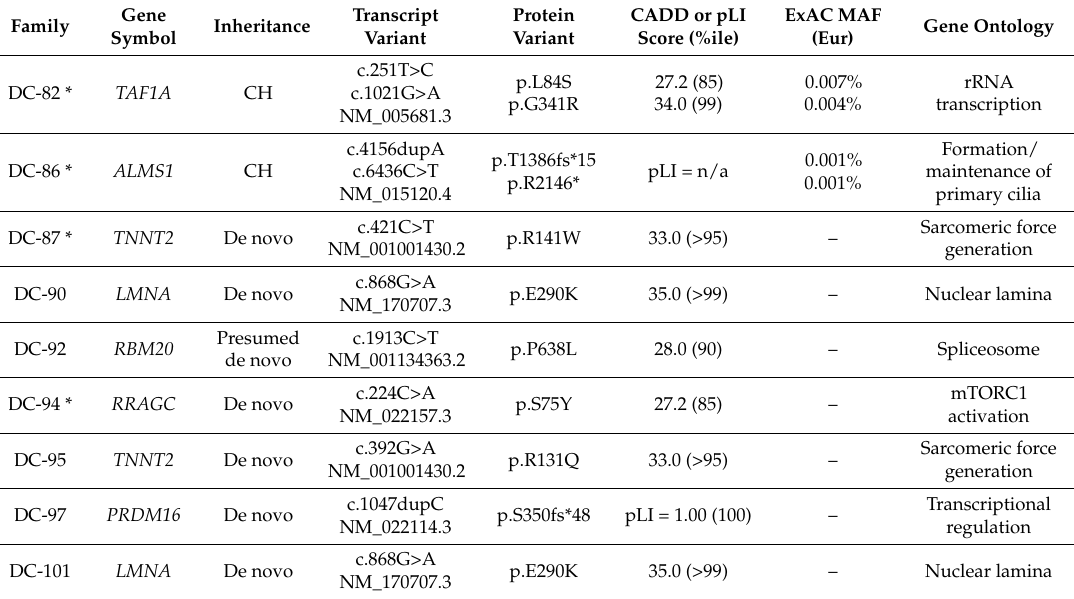
Table 1. Mutations identified in DCM